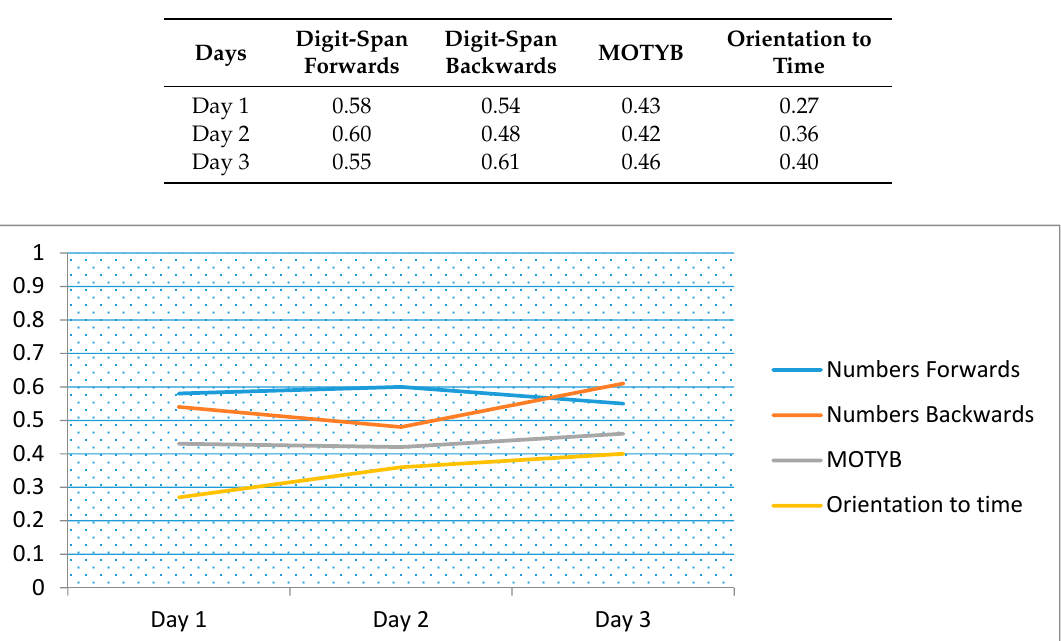
Table 3. Correlation coefficients (Spearman’s rho) for logical memory and short tests of attention including months of the year backwards (MOTYB). (Note: n = 83/84 with complete data included; values day 4 and 5 were excluded).